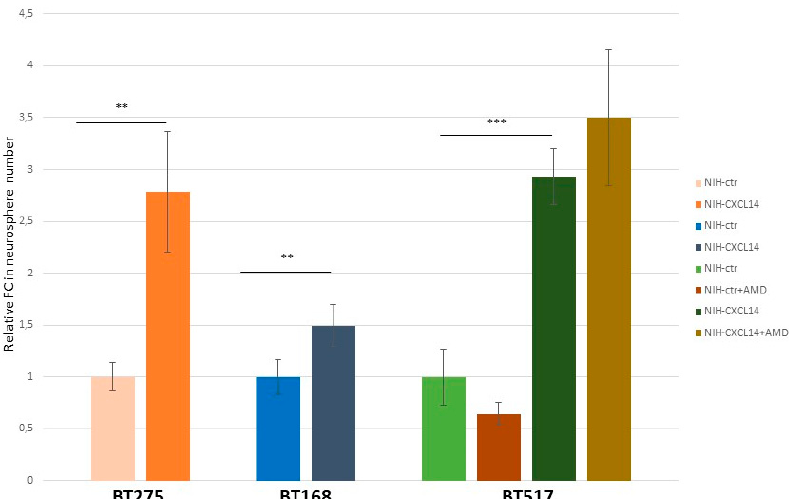
Figure 6. Exogenously supplemented CXCL14 enhances the self-renewal ability of glioblastoma stem cells. Glioblastoma stem cell self-renewal assay. The histogram shows the fold change (FC) in numbers of neurospheres formed by three different glioblastoma stem cell lines, BT275, BT168, and BT517. The results were obtained by counting the number of neurospheres in four random fields per sample, and comparing cells grown in the presence of NIH-ctr conditioned medium to cells grown in the presence of NIH-CXCL14 conditioned medium. For BT517 cells, the assay was performed in either the presence or the absence of AMD3100 ( n = 3; mean ± S.D.). ** p -value < 0.01; *** p -value < 0.001.